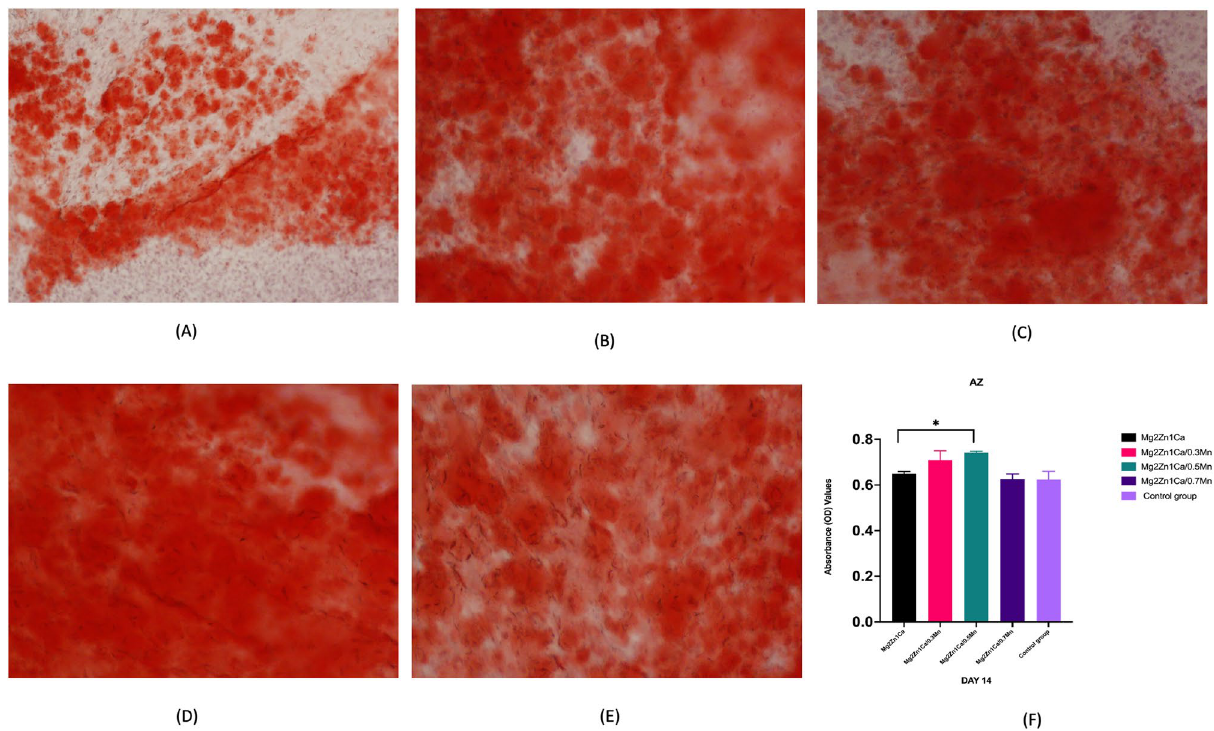
Figure 5. Alizarin red staining was used to determine the extracellular calcium deposition ( A ) Negative Control (Osteogenic media with cells), ( B ) Mg2Zn1Ca, ( C ) Mg-2Zn-1Ca/0.3Mn, ( D ) Mg-2Zn-1Ca/0.5Mn, ( E ) Mg-2Zn-1Ca/0.7Mn, ( F ) Quantitative measurements of Alizarin red activity in MC3T3-E1 cells after 14 day of culture. The cells cultured with osteogenic media without alloy extracts were used as control. Addition of Mn showed increased calcium deposition and staining. Error bars indicate mean ± standard deviation ( n = 3, independent samples). (* P <